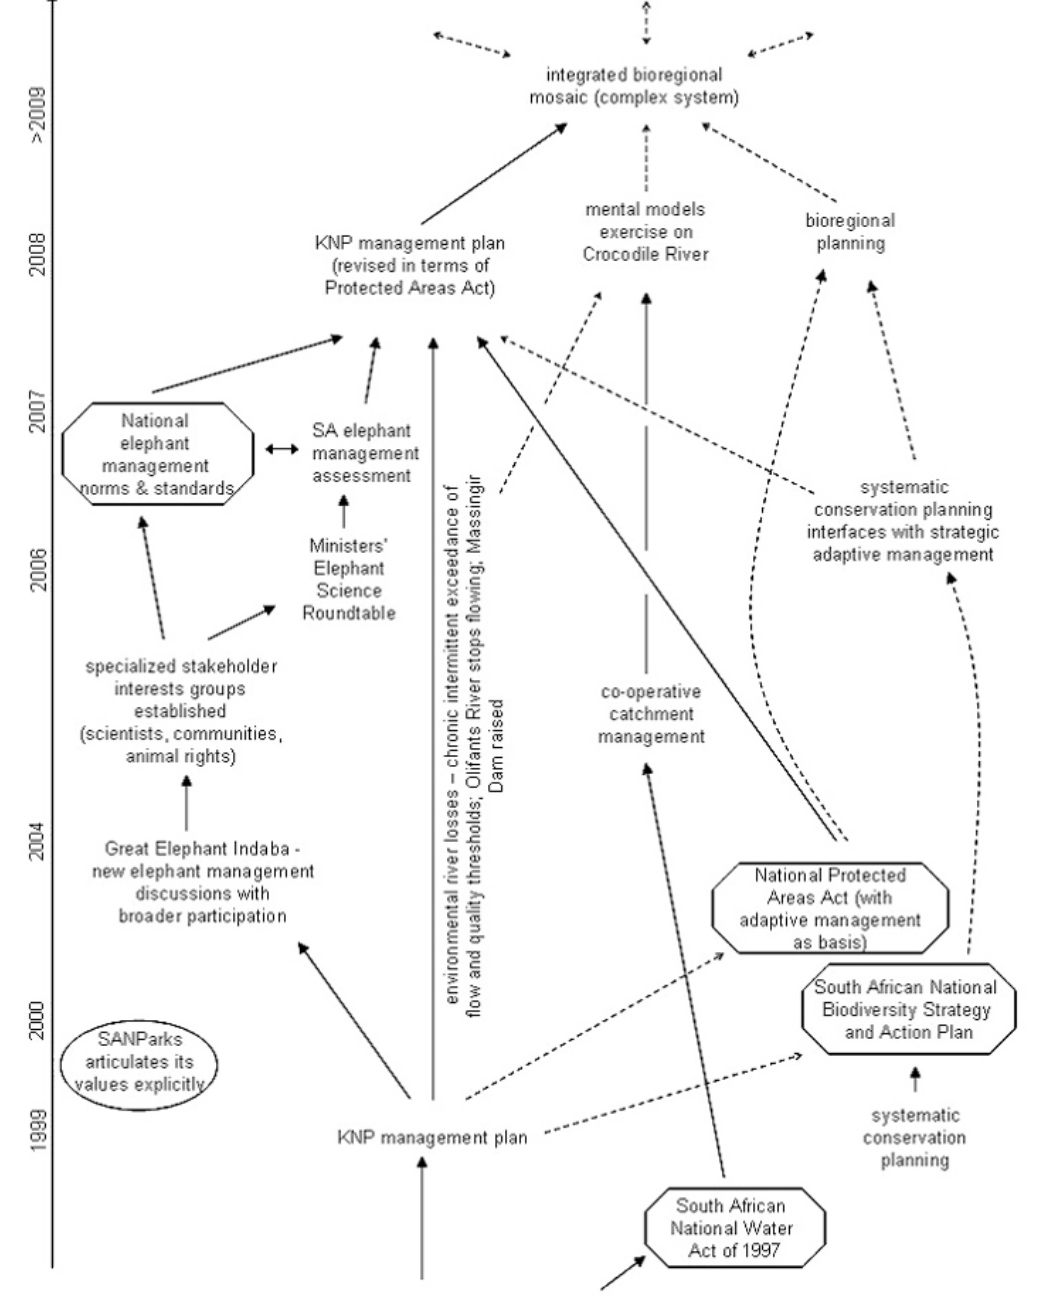
Fig. 3 . The further spread of strategic adaptive management approaches during the second decade, the 2000s. Solid arrows denote direct influence and interaction, and dotted lines show indirect